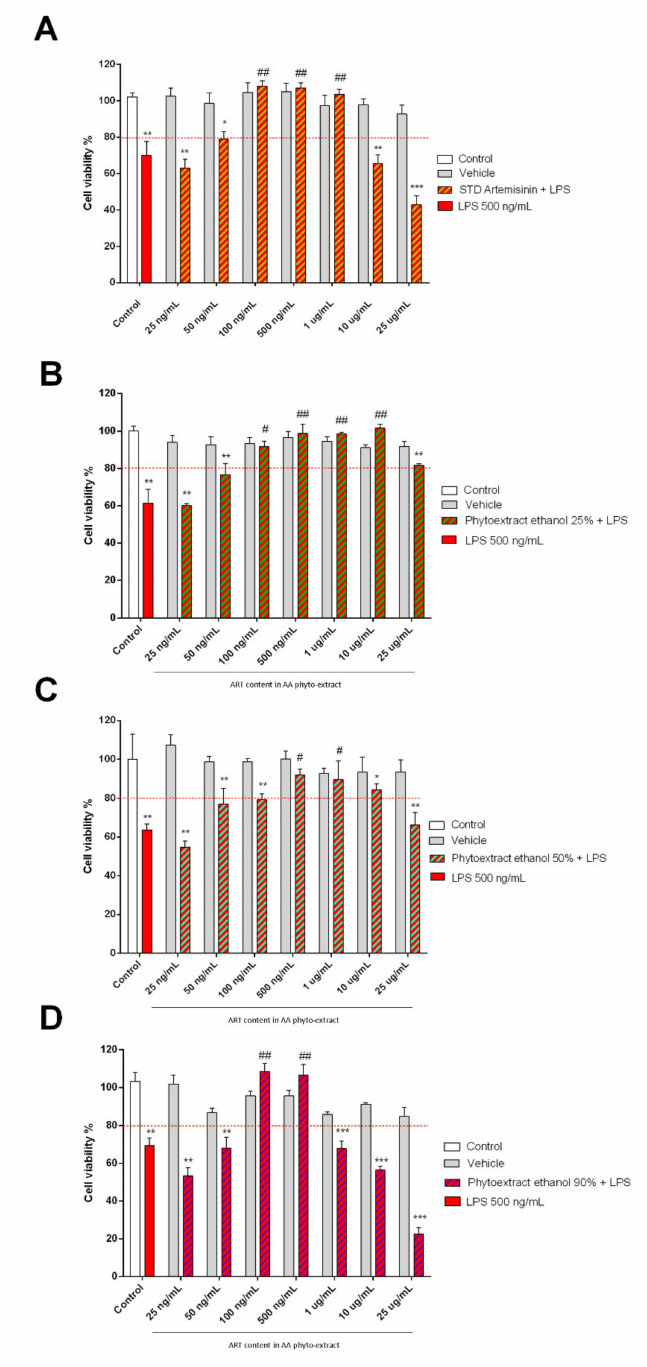
Figure 7. Protective effect of ethanolic extracts of Artemisia annua L. in SH-SY5Y cells after LPS pro-inflammatory insult. Cell viability of SH-SY5Y cells subjected to 24 h of co-treatment with LPS and Artemisinin standard ( A ), AA hydroalcoholic phyto-extract in ethanol 25% ( B ), 50% ( C ), and 90% ( D ). Phyto-extract treatments were performed so that the ART content within the phyto-extracts was at the same concentration of STD Artemisinin. This estimation was calculated based on the phyto-extract ART quantification by HPLC. Cell viability was measured with the MTT assay and is expressed as a percentage of the control (white column) that did not receive any treatment. Data are expressed as mean ± standard error of the mean: *** p ≤ 0.001, ** p ≤ 0.01 and * p < 0.05 versus untreated cells and ### p ≤ 0.001, ## p ≤ 0.01 and # p ≤ 0.05 versus